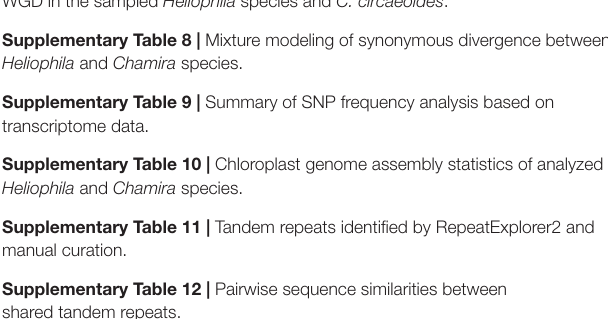
Supplementary Table 5 | List of selected chloroplast genomes and their respective GenBank accession numbers used in maternal phylogeny inference. Supplementary Table 6 | Repetitive elements investigated by FISH.